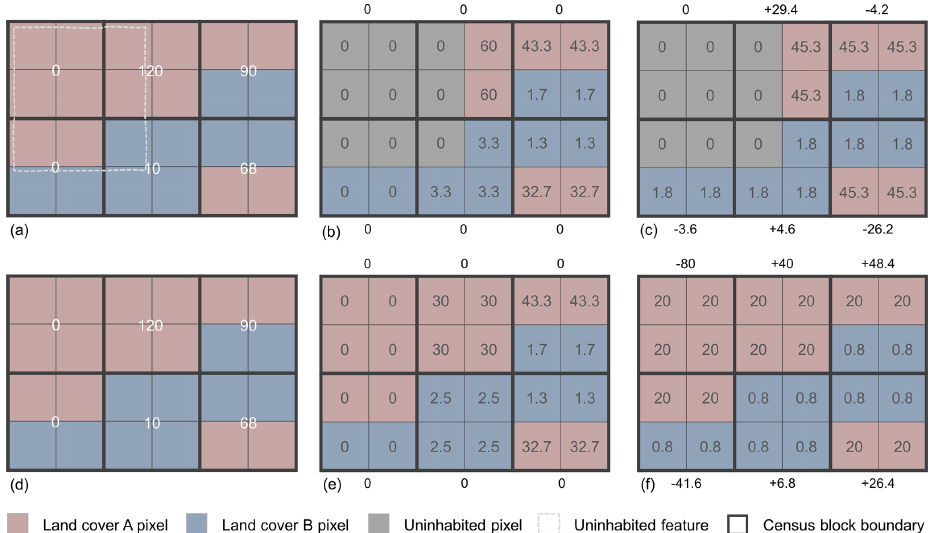
Figure 3. A simulated illustration of six census blocks and associated population within a single census tract (a, d) . This tract has two land cover types, A and B, with representative population densities estimated at 5.0 and 0.2, respectively, and an uninhabited feature that is new to the updated specification of uninhabited areas. Block level errors are provided adjacent to each block. Because our method has no cumulative error at the block level (b, e) , we assessed our representative population densities by applying the densities at the tract level (i.e., no cumulative error at the tract level) with the updated specification of uninhabited areas (c) and the 2016 specification of uninhabited areas (f) . In this illustration the tract has a MAE of 40.6 with the 2016 specification of uninhabited areas (f) and 11.3 with updated specification of uninhabited areas (c) . Note that for illustrative purposes in this figure, we used the same representative population density estimates for both updated (a–c) and 2016 (d–f) specifications. In practice the representative population density estimates for the updated and 2016 specifications were determined independently and most likely would have been different.